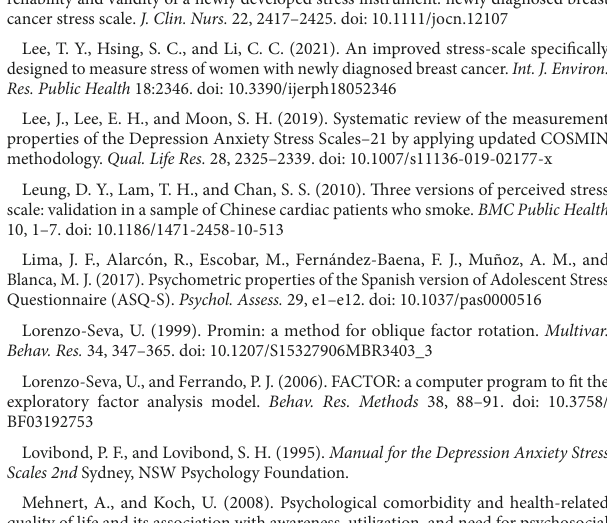
Inventory (SSI-SM) [Spanish adaptation of the stress manifestations scale of the Student Stress Inventory (SSI-SM)]. Psicothema 23, 475–485. Figalová, N., and Charvát, M. (2021). The perceived stress scale: reliability and validity study in the Czech Republic. Československá Psychologie 65, 46–59. doi: 10.51561/